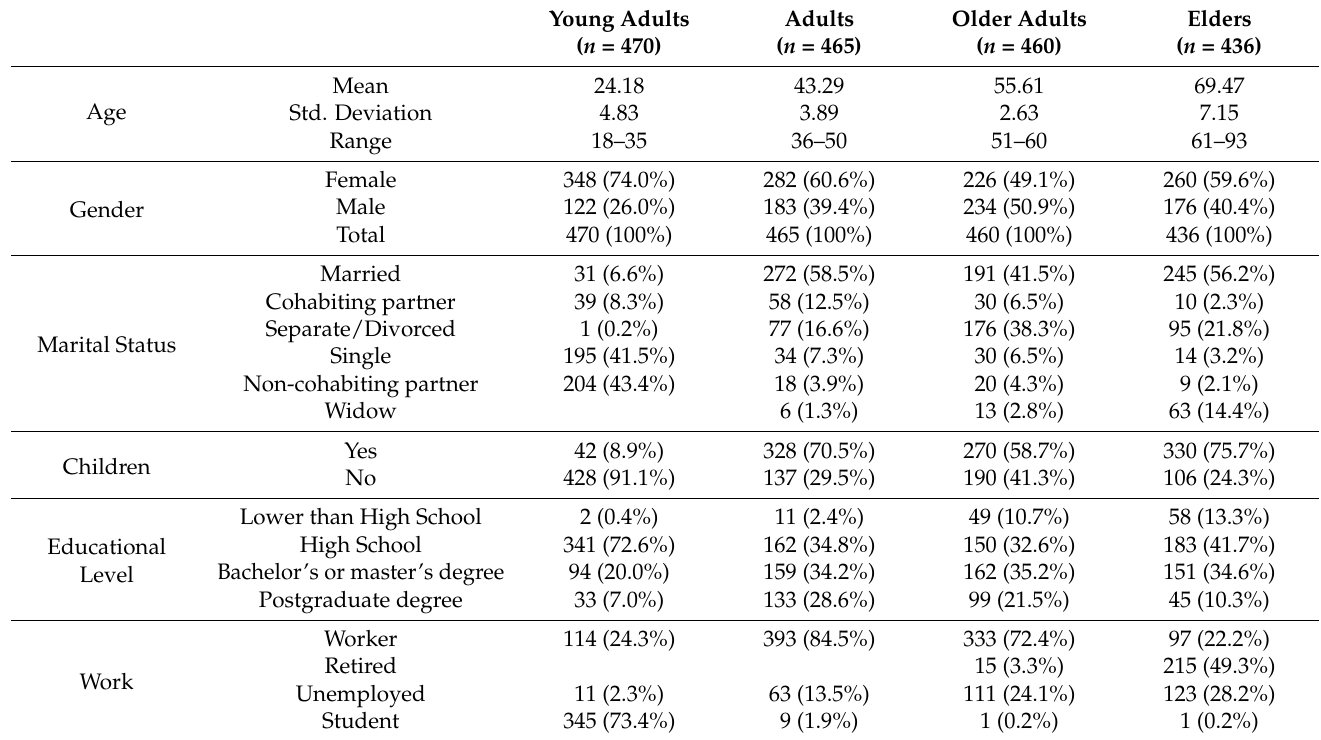
Table 1. General characteristics of the enrolled sample ( n =